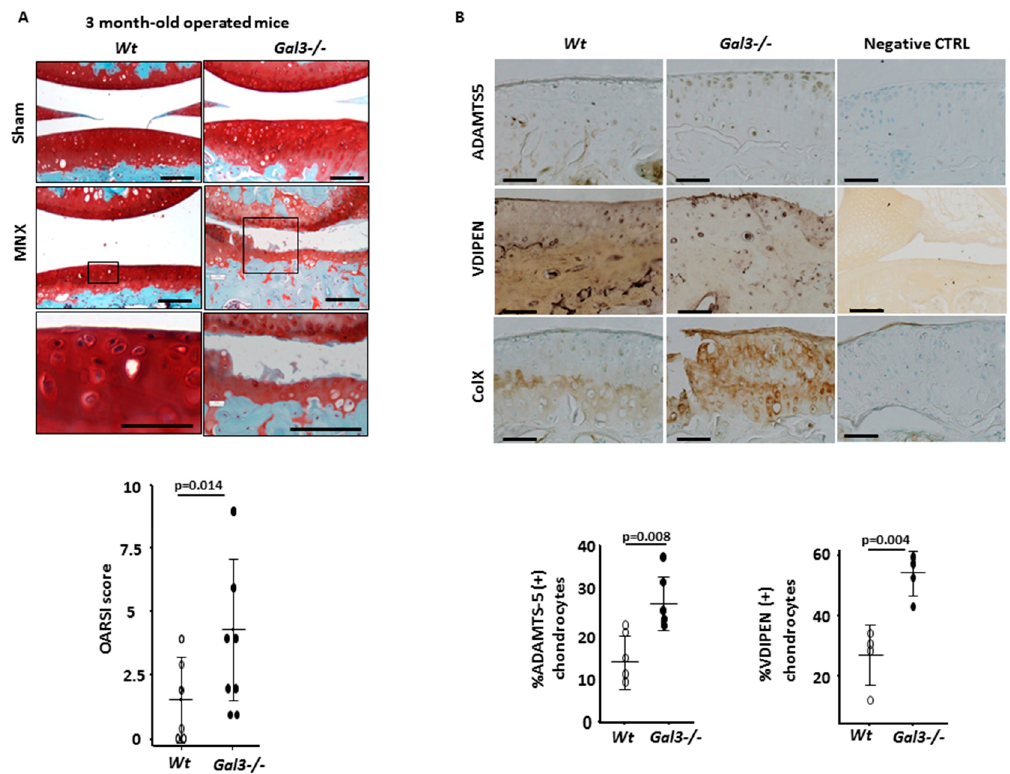
Figure 2. GAL3 deficiency induces OA during mechanical stress. ( A ) Knee cartilage sections stained with safranin-O after joint meniscectomy (MNX) or sham operation in 3-month-old mice ( n = 8 mice for WT and Gal3 − / − ). Low (top panels) and high (low panels) magnification are presented. OA lesions were assessed by OARSI score (low panel). ( B ) Immunohistochemistry of expression of ADAMTS-5 ( n = 5 WT and Gal3 − / − mice), VDIPEN ( n = 4 WT and Gal3 − / − mice) and type X collagen ( n = 8 WT and Gal3 − / − mice). The percentage of ADAMTS-5– and VDIPEN-positive chondrocytes in Gal3 − / − and WT cartilage was counted (( B ), low panel). Negative controls were nonspecific IgG antibodies. Scale bars: 100 µm. Two-tailed Mann Whitney U test between WT and Gal3 − / − .